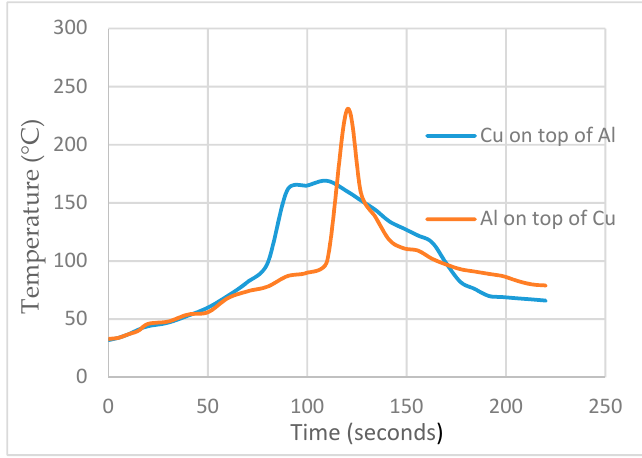
Figure 13. Temperature distribution curves of 2219 Al-Cu and Cu-2219 Al fabricated by WC at S 1500 rpm and F 30.0 mm/min.